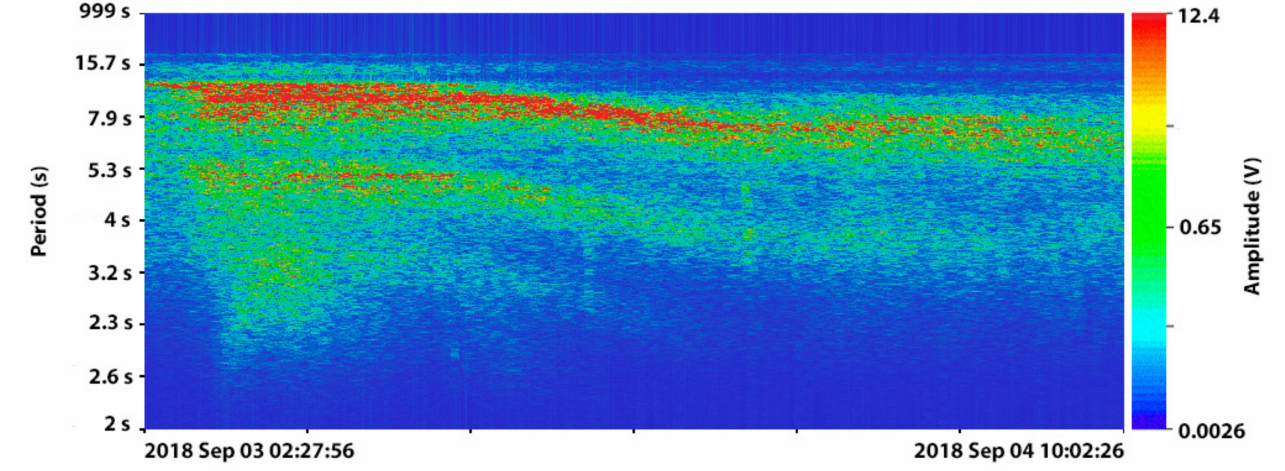
Figure 4. Dynamic spectrogram of a record of laser meter of hydrosphere pressure